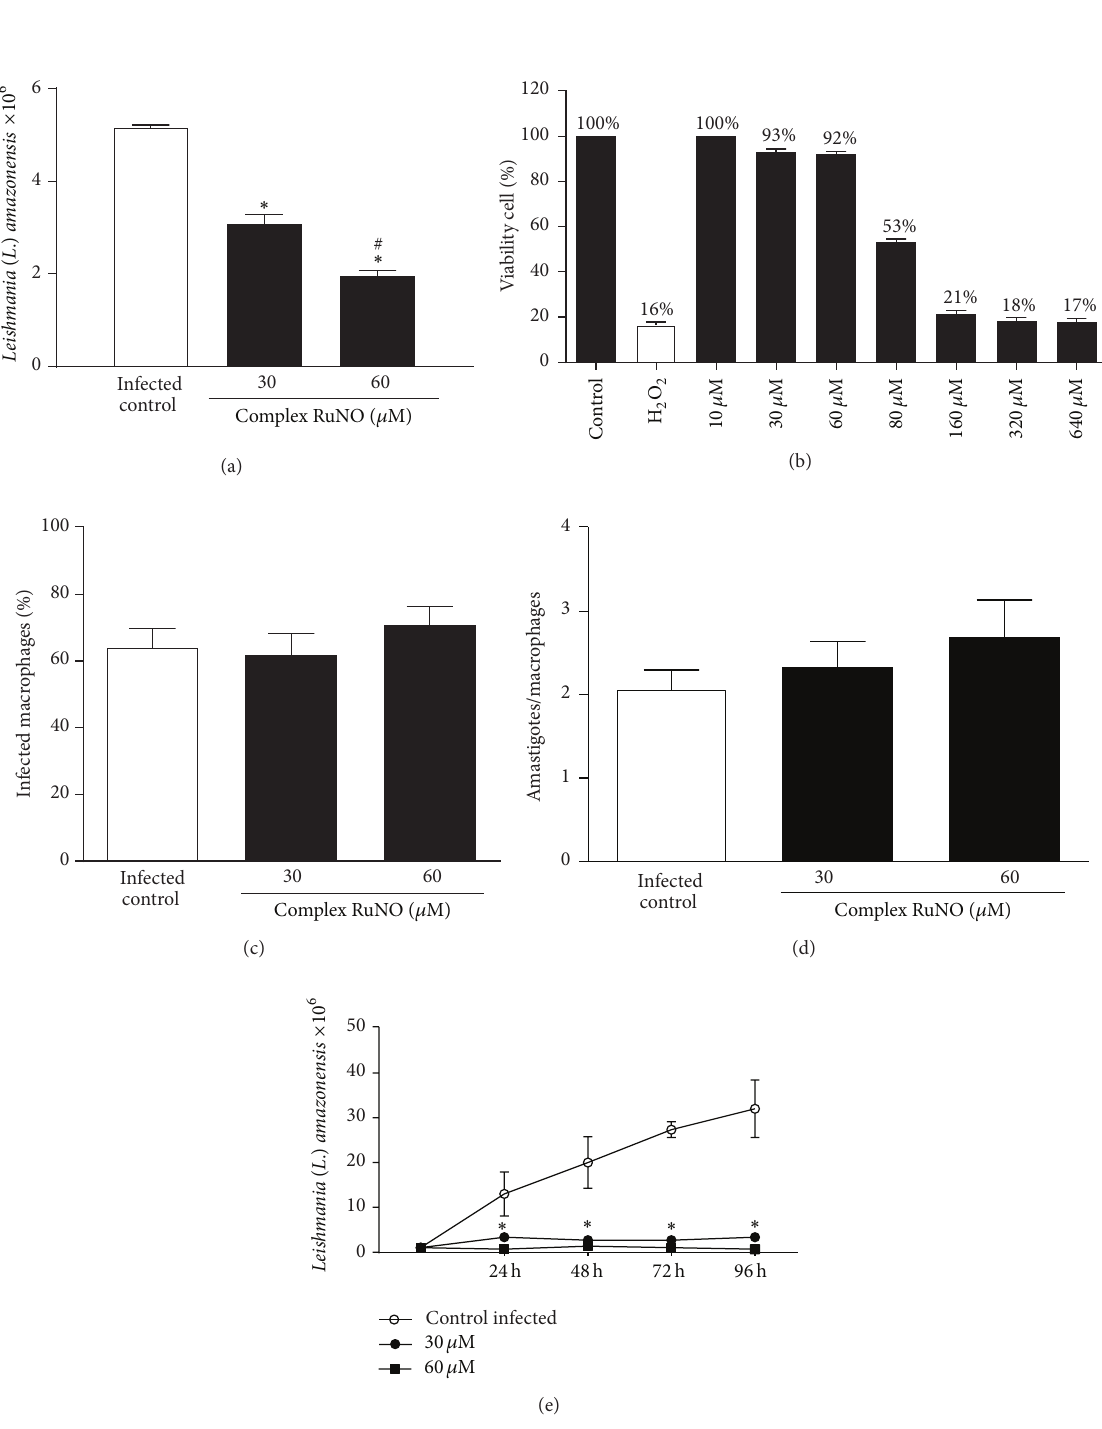
Figure 1: Antileishmanial activity by ruthenium complex. (a) Amount of L. amazonensis promastigote forms after treatment with RuNO complex (30 and 60 𝜇 M) for 24 h. [Values represent the mean ± SEM of three independent experiments ( 𝑃 < 0.05 ). ∗ Significantly different from infected control. # Significantly different between concentrations]. (b) Viability of peritoneal macrophages of BALB/c mice treated with RuNO complex (10–640 𝜇 M) for 24 h. [Values represent the mean ± SEM of three independent experiments]. (c) Percentage of infected macrophages after 24 h of incubation with RuNO complex (30 and 60 𝜇 M). (d) Mean number of amastigotes per macrophage after 24 h of incubation with RuNO complex (30 and 60 𝜇 M). (e) Recovery kinetics of promastigotes that had infected peritoneal macrophages, which were then treated with RuNO complex (30 and 60 𝜇 M). [Values represent the mean ± SEM of three independent experiments ( 𝑃 < 0.05 ). ∗ Significantly different from